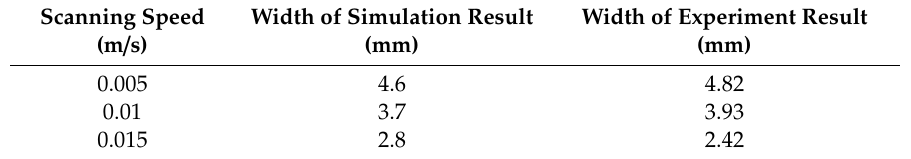
Table 4. The width of the molten pool provided by the simulation result and the experiment result. Scanning Speed